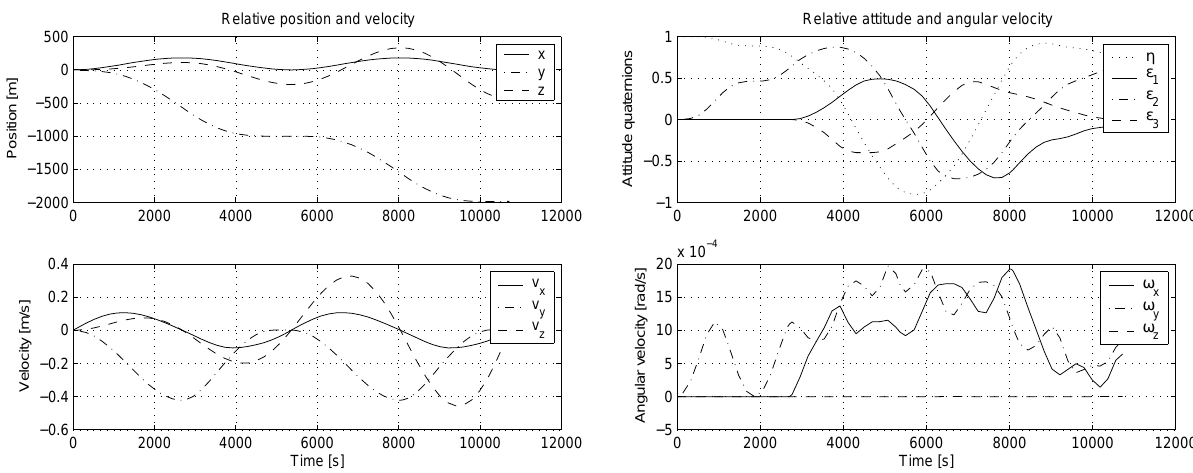
Figure 4: Relative position and velocity between leader and follower spacecraft.